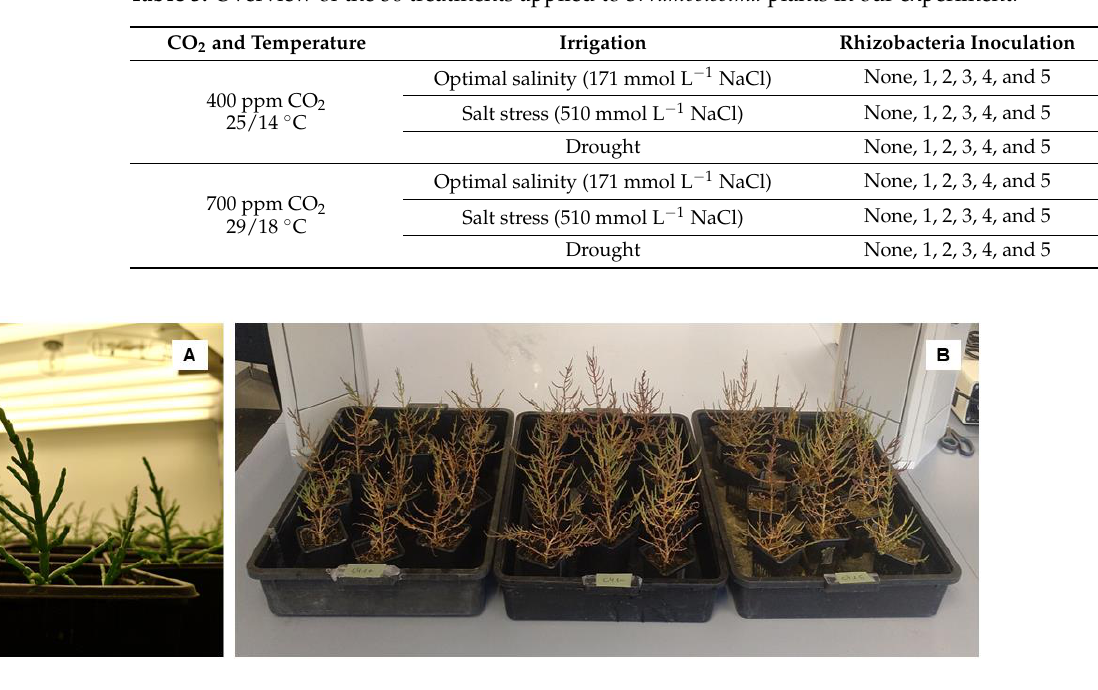
Figure 4. Pictures of Salicornia ramosissima ( A ) during the experiment inside the controlled environ- ment chamber and ( B ) at the end of the experiment before sample processing (trays shown were grown in the high temperature and CO 2 chamber, with saline, optimal, and deficient irrigation, and inoculated with bacterial consortium number 4).